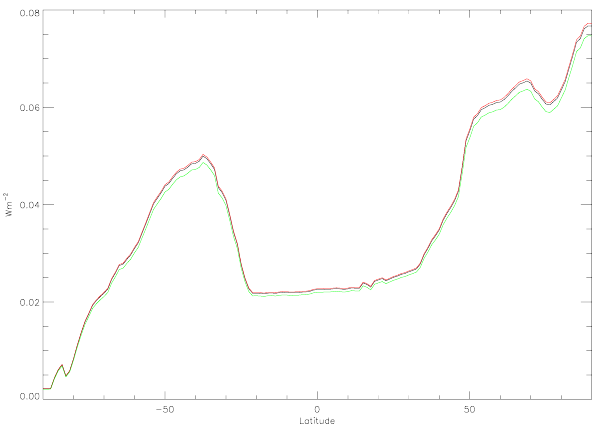
Fig. 6. Zonal-mean net tropopause forcing in which halocarbons controlled under the Montreal and Kyoto Protocol are represented as one equivalent species each, CFC-12 and HFC-134a, respectively (black line). The sensitivity tests with Montreal gases split into individual species (red line) and Kyoto gases split into individual species (green line) show a close